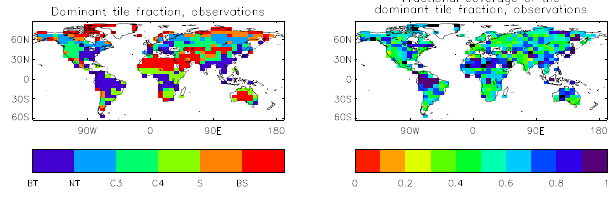
Fig. 1. The left-hand figure shows the observed dominant plant functional type for the present-day (Loveland et al., 2000) and the right-hand figure shows the fractional coverage of the dominant type. BT (broadleaf tree), NT (needleleaf tree), C3 and C4 vege- tation and S (shrubs) and BS (bare soil).